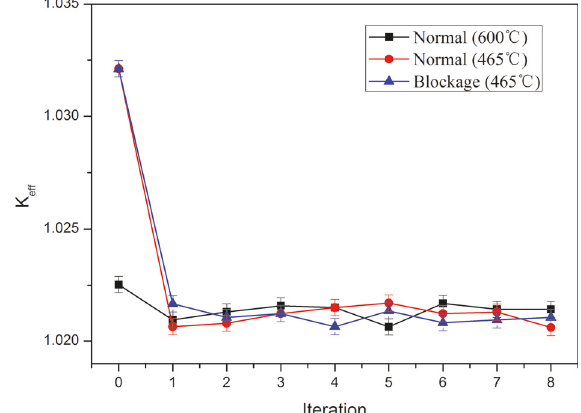
Figure 5: k eff as a function of iteration number (black dot line: initial temperature is set at 600 ∘ C during the normal operating state; red dot line: initial temperature is set at 465 ∘ C during the normal operating state; blue dot line: initial temperature is set at 465 ∘ C during the central fuel assembly partly blocked state).